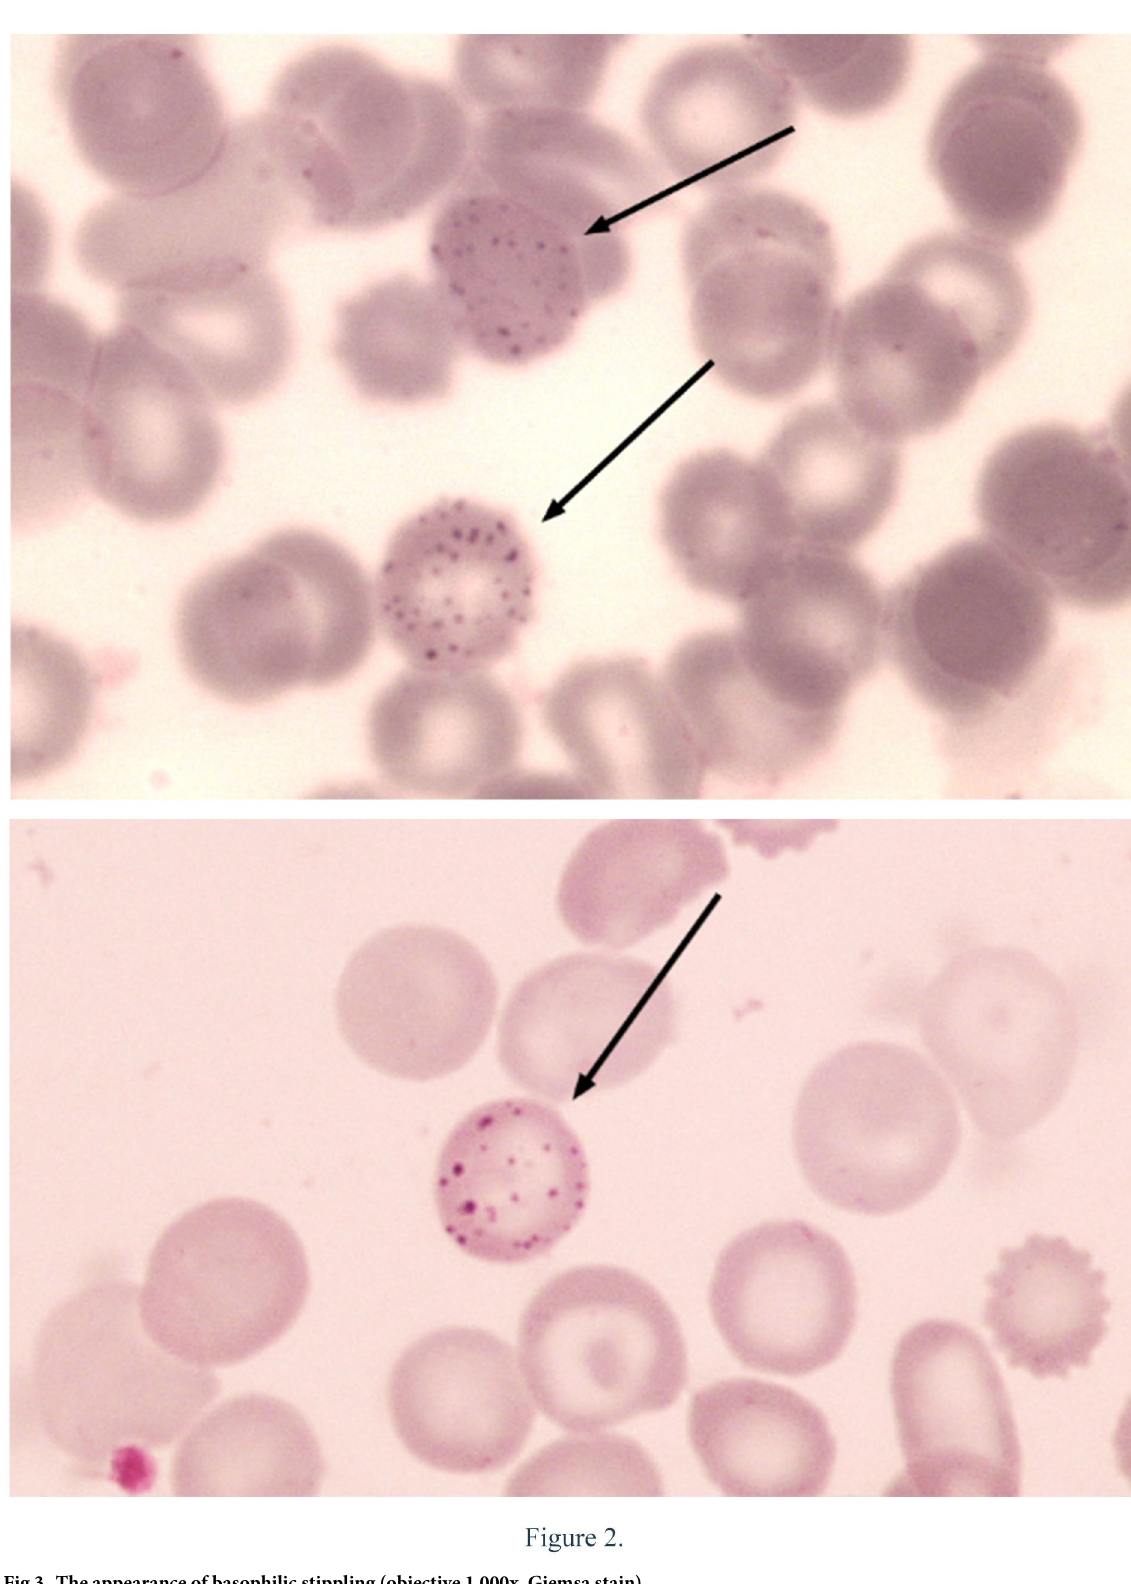
Fig 3. The appearance of basophilic stippling (objective 1.000x, Giemsa stain).